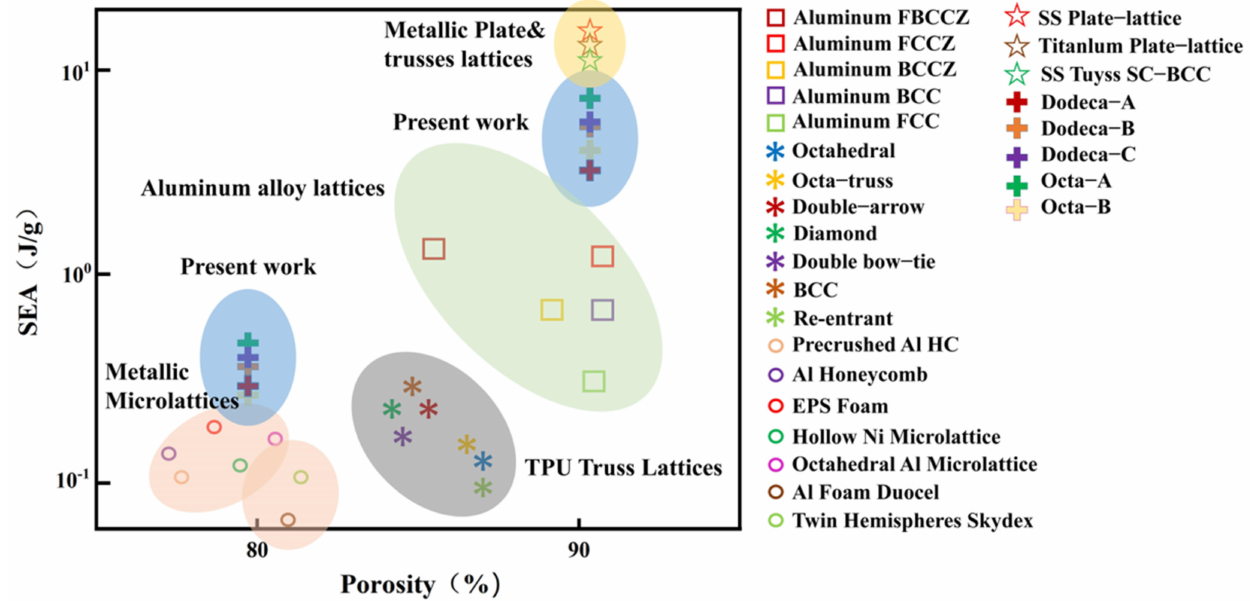
Figure 10. Comparison of specific energy absorption of the porosity structure considered in the present work with the extant literature